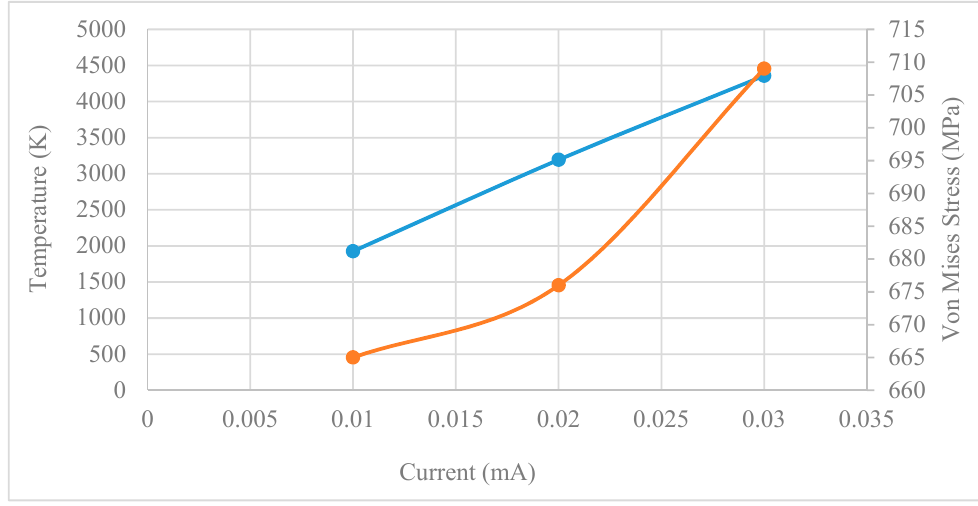
Figure 25. Current vs. temperature& Von Mises Stress.